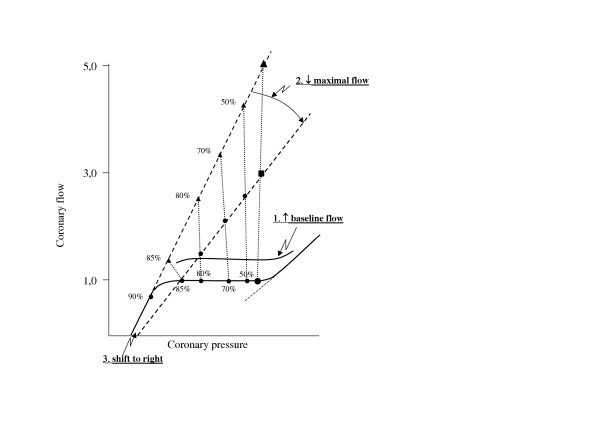
Complexity of CFR concept. Percent values on the curves represent the severity of coronary epicardial stenosis.